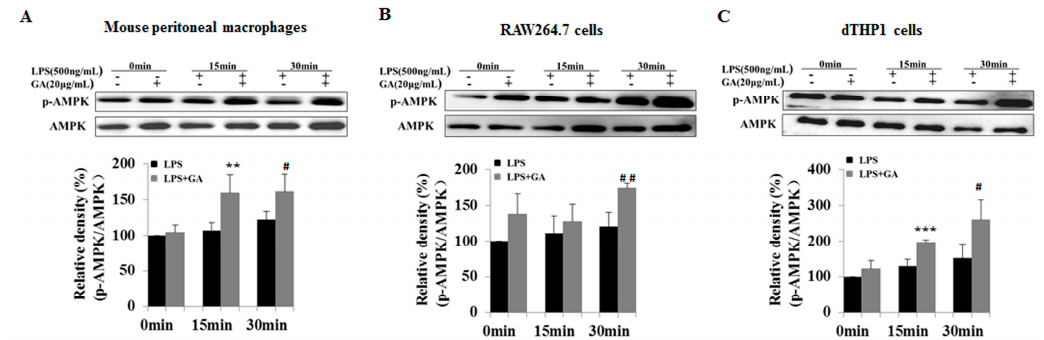
Figure 5. GA upregulates AMPK signaling in LPS-stimulated macrophages. ( A ) Mouse peritoneal macrophages; ( B ) RAW264.7 cells; and ( C ) dTHP-1 cells were treated with the same method as in Figure 4. Cell lysates were prepared and analyzed for phosphorylation of AMPK by Western blotting. The histograms below the blots show relative density ratios (fold changes) measured by Image J. Values are presented as means ± SD of three independent experiments. ** p < 0.01; *** p < 0.001 versus LPS group at 15 min; # p < 0.05, ## p < 0.01 versus LPS group at 30 min. AMPK, AMP-activated protein kinase.